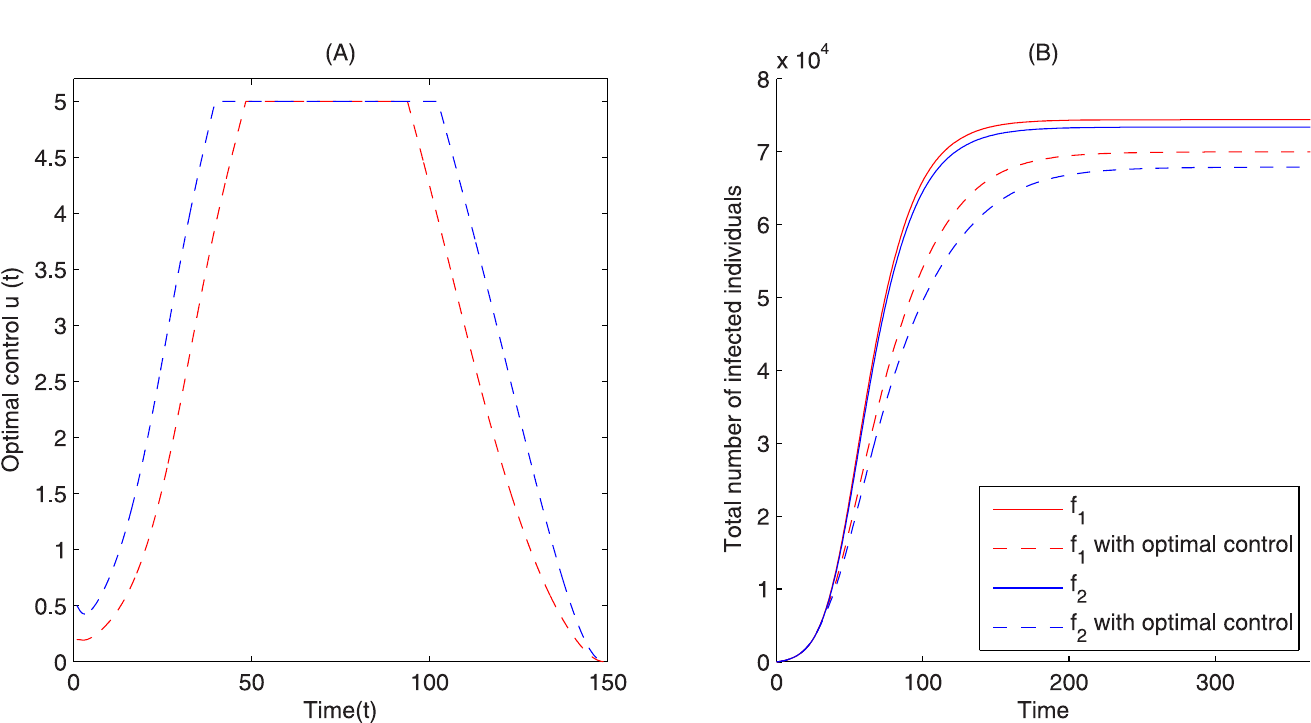
Fig 9. Optimal control. (A) The optimal control u ( t ) for the optimal control problem (4) obtained by using Forward-Backward sweep method. The red and blue dashed curves represent the optimal control for system (4) with different media functions f 1 and f 2 , respectively. (B) Comparison of total infections for system (1) and the optimal control system (4). A = 1, B = 5, u max = 5, t 0 = 0, t = 150, all other parameters are shown in Table 1. end